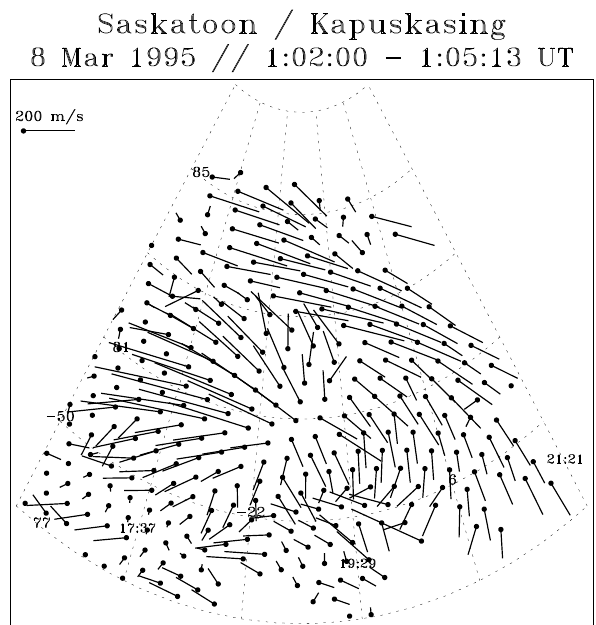
Fig. 1. Example of small-scale expanding structure seen by the Saskatoon/Kapuskasing pair of SuperDARN HF radars (from Andr´e, 1997).